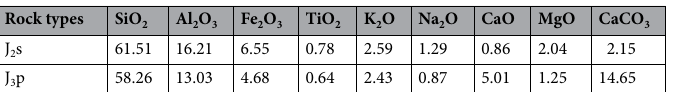
Table 2. Major chemical element contents (%) of the two purple mudstones.